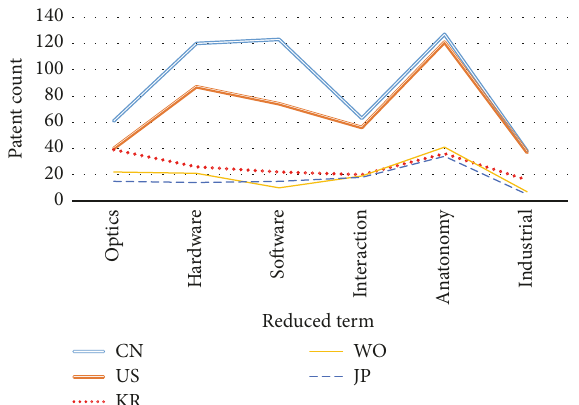
Figure 9: IIT patent topic distribution of top countries.